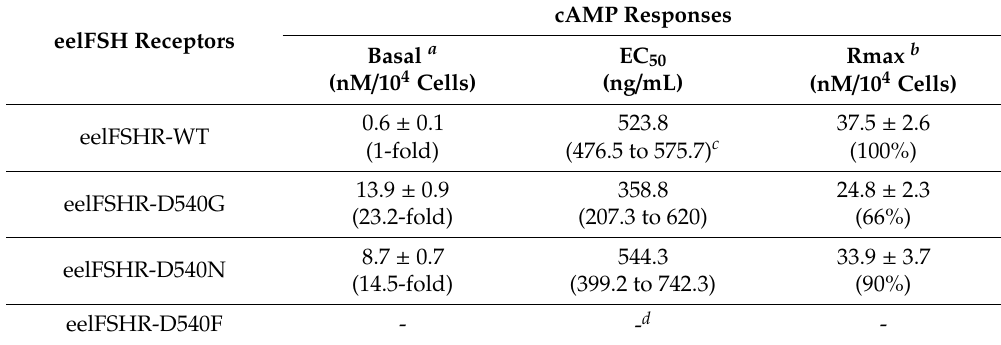
Values are the means ± SEM of three experiments. The half maximal e ff ective concentration (EC 50 ) values were determined from the concentration–response curves from in vitro bioassays. a Basal cAMP level average without